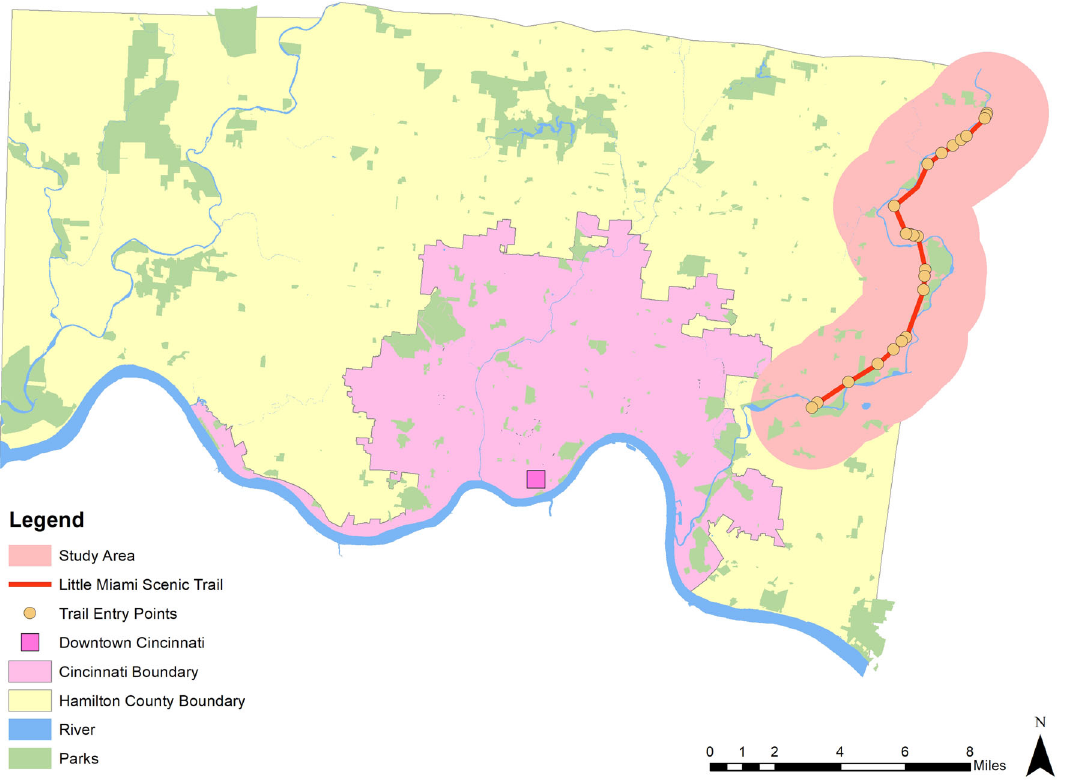
Fig. 1 Location of the study